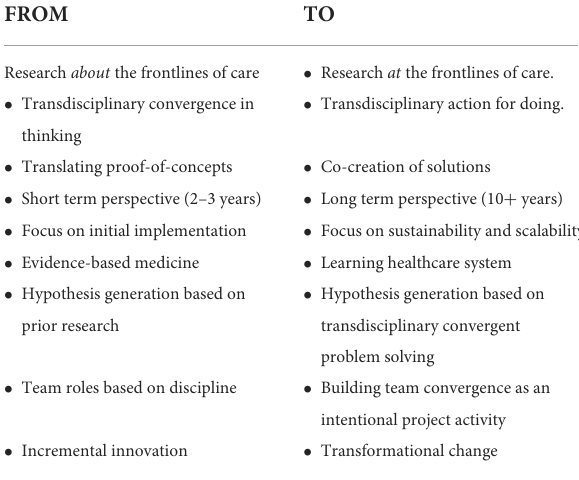
TABLE 1 Research paradigm shifts inherent in healthcare delivery science. FROM